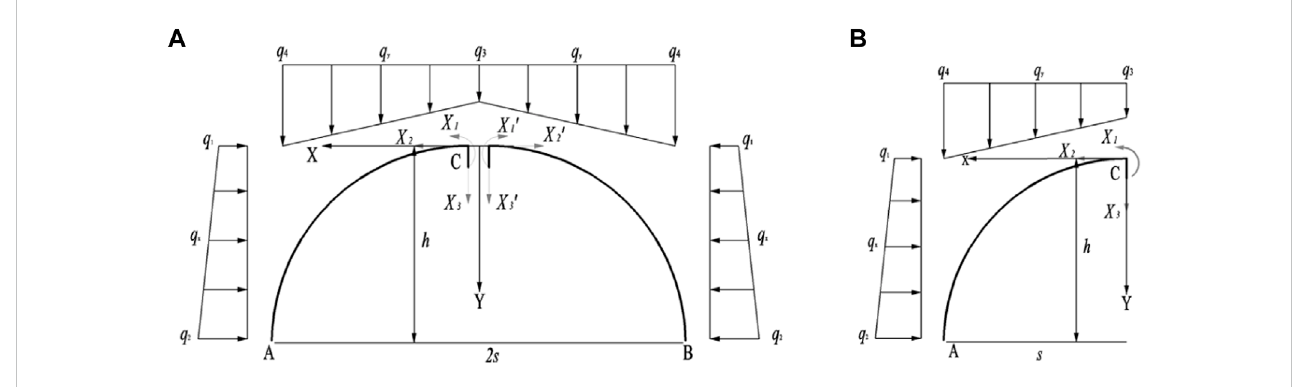
FIGURE 2 Calculating model of internal force of SRPA (Surrounding rock pressure arch): (A) Stress analysis, (B) Left half-span